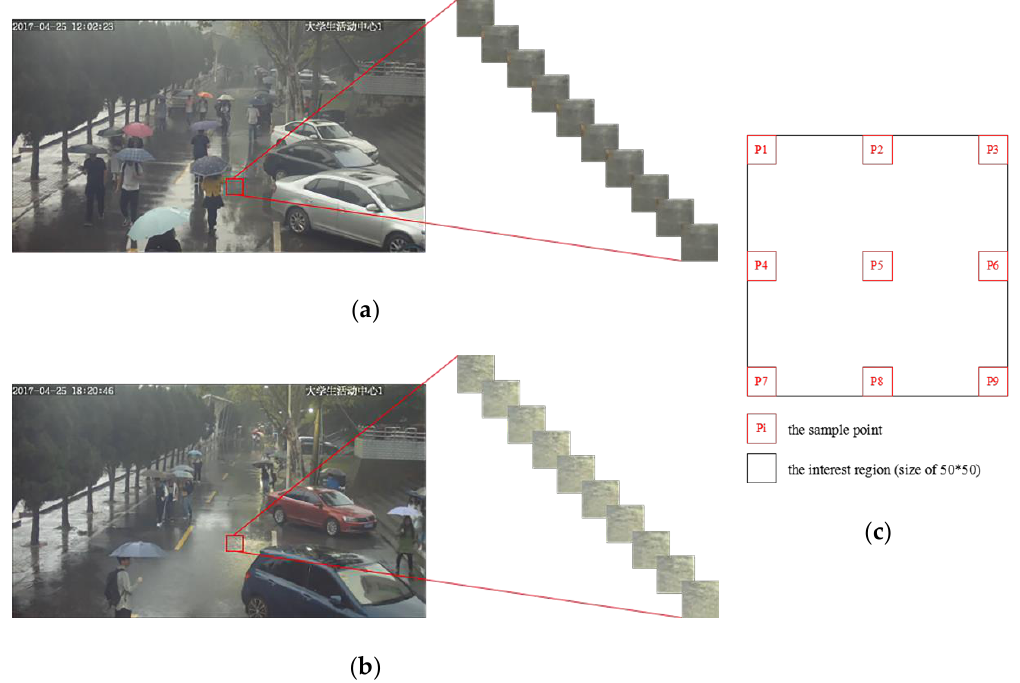
Figure 11. Image series in different conditions: wet areas ( a ) and inundated areas ( b ), and the position of sample points ( c ).